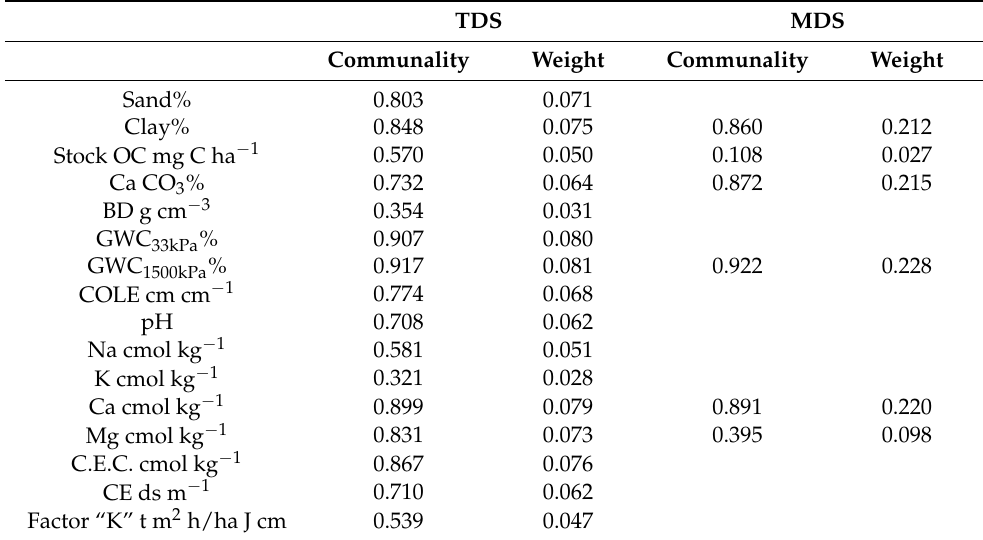
Table 4. Result of the estimated community and the value of the weight of each indicator in both TDS and MDS